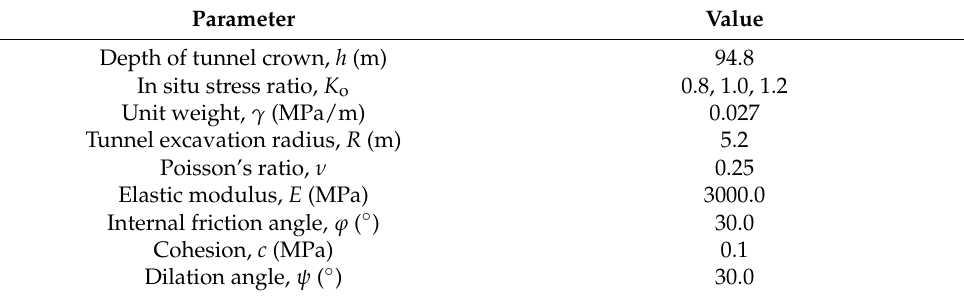
Table 1. Input data required for calculation.